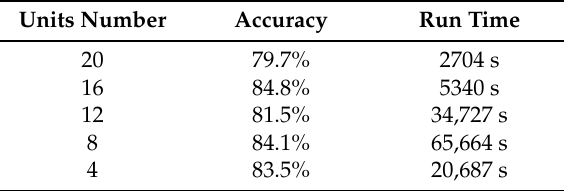
Table 6. Performance of three-layer BP neural network with different hidden units.